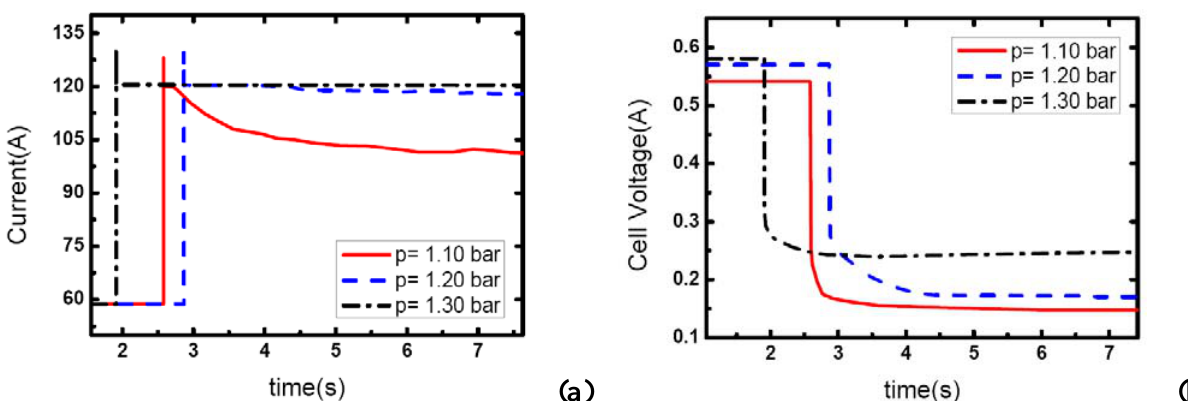
Figure 7. (a) Current change at three different operating pressures while λ 1.46, (b) corresponding dynamic responses of voltage.